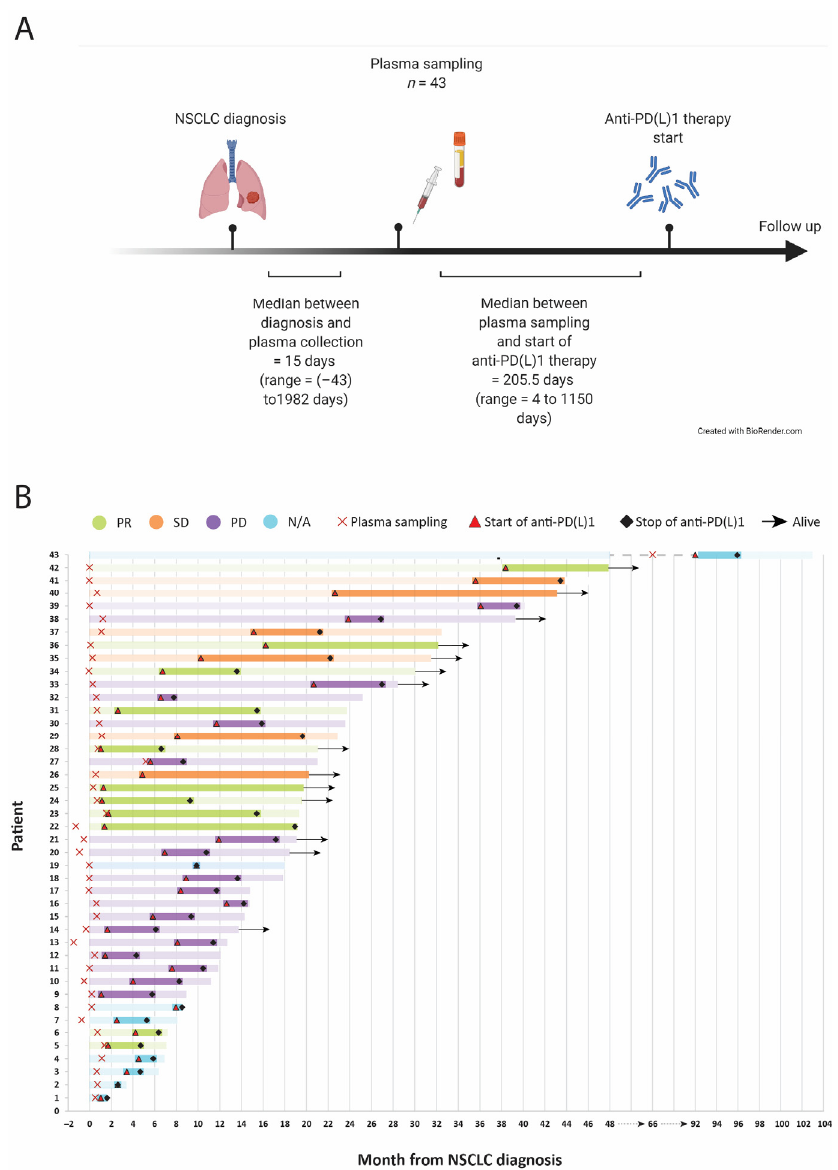
Figure 1. Workflow and clinical events. ( A ) Sequential workflow for diagnosis, sampling, and therapy initiation. The number of samples ( n ), the median days, and the time range between sampling and diagnosis or therapy start are noted. ( B ) Swimmer plot illustrating the individual patients’ clinical courses of treatment start and stop, sampling, and outcome.